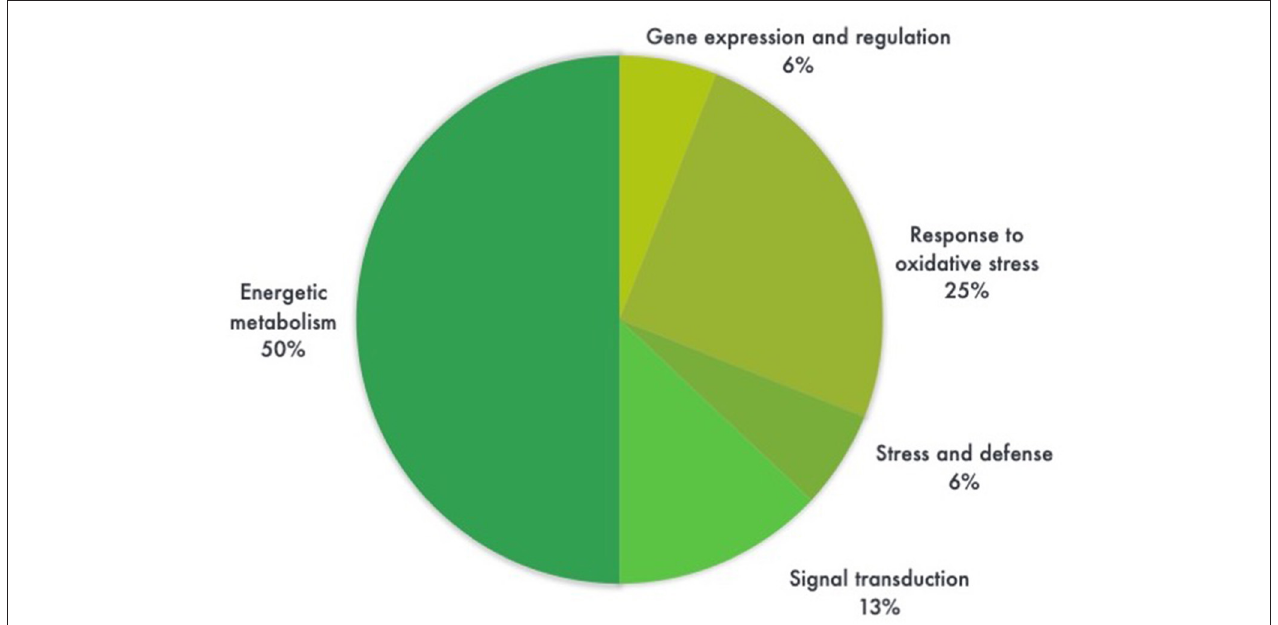
FIGURE 5 | Pie chart distribution of differentially expressed proteins (ANOVA, P < 0.05) between leaf samples of genetically modified maize (MON810 event) and non-transgenic isogenic (PAN 6Q-121) based on the function of the proteins. Protein functions were predicted according to Gene Ontology terms. N = 16, whereas 6% correspond to a single